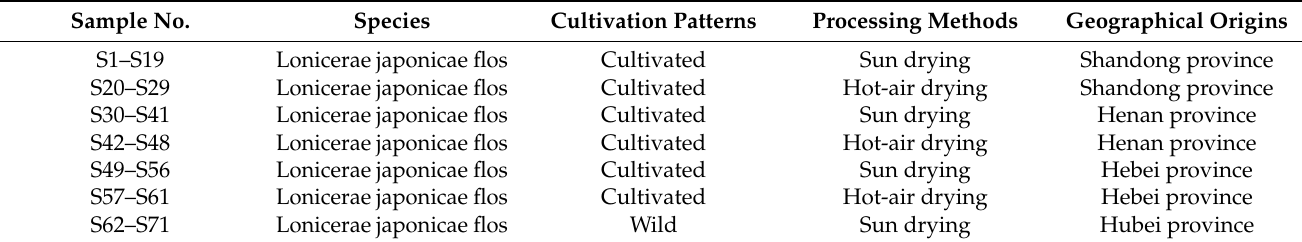
Table 6. Detailed information of the LJF samples analyzed in this study. Sample No. Cultivation